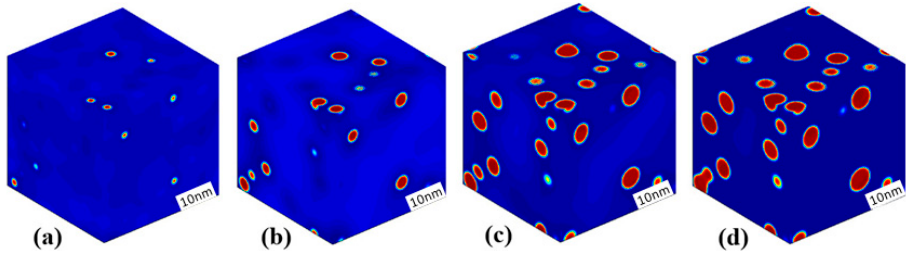
Figure 2. 3D morphology evolution of the Cr-enriched α′ phase in the Fe-25 at % Cr alloy aged at 750 K, 750 K, ( a ) t = 46 h; ( b ) t = 115 h; ( c ) t = 5390 h; ( d ) t = 6773 ( a ) t = 46 h; ( b ) t = 115 h; ( c ) t = 5390 h; ( d ) t = 6773 h.